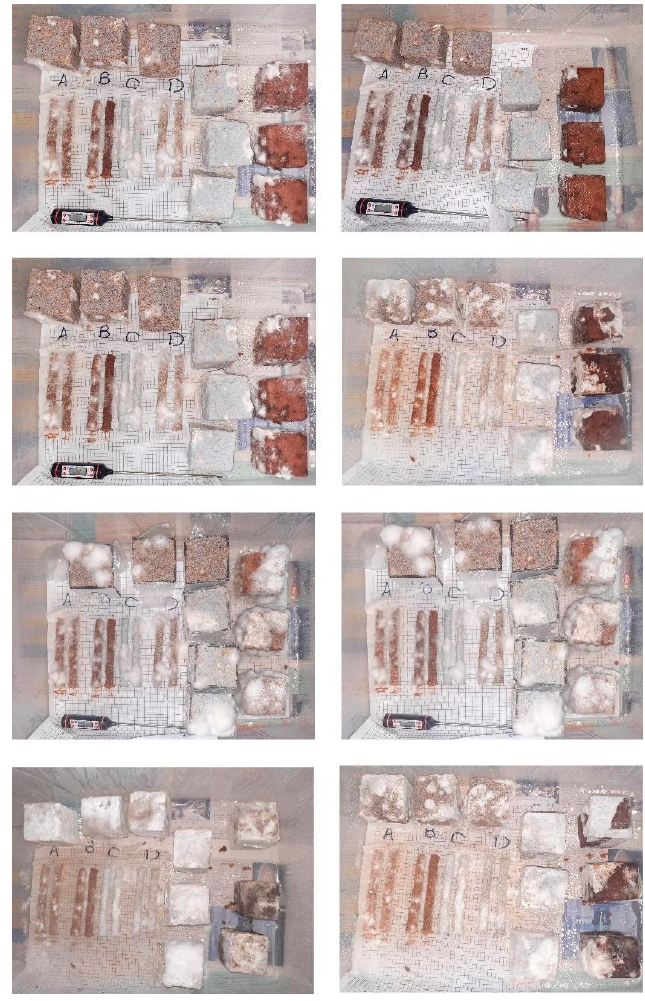
Figure 6. Initial material tests for examining treatments’ cultivation and gelling agents’ performance (Image credit: Authors). Table 1. Mixture Properties for the First set of